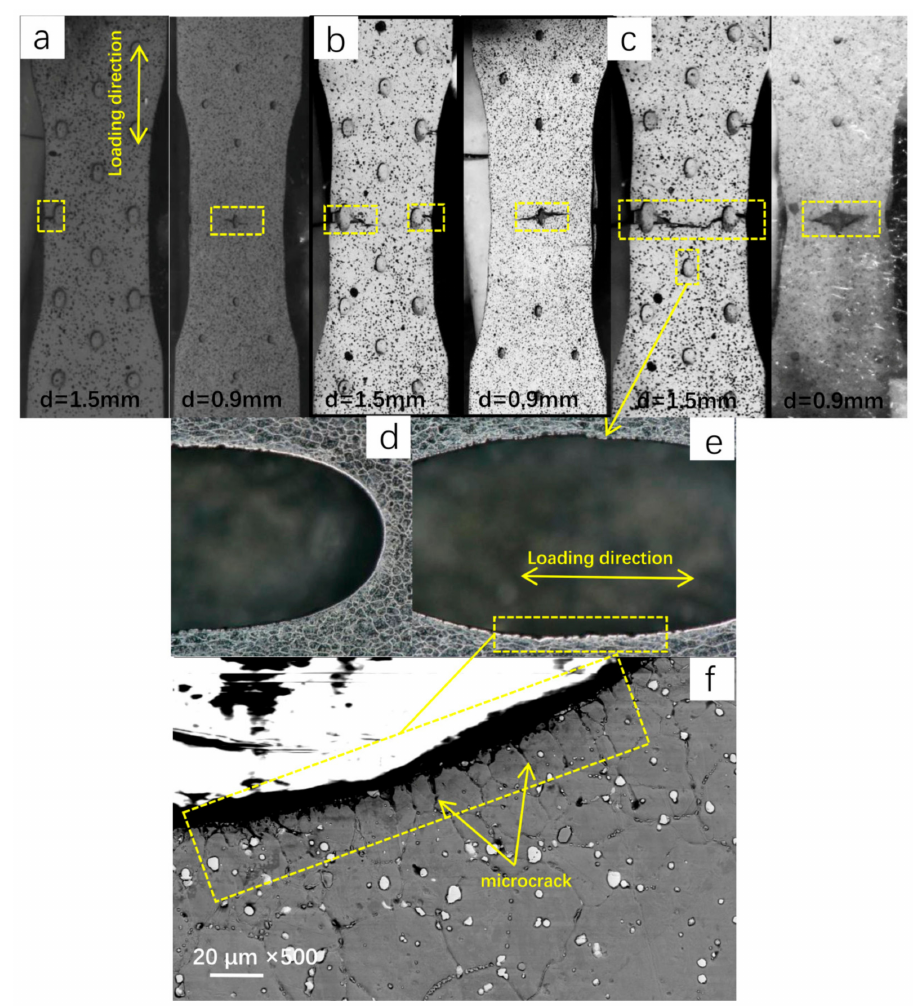
Figure 5. Images of test pieces during testing: ( a ) 650 ◦ C; ( b ) 750 ◦ C; ( c ) 850 ◦ C; ( d – f ) microcracks around the hole at 850 ◦